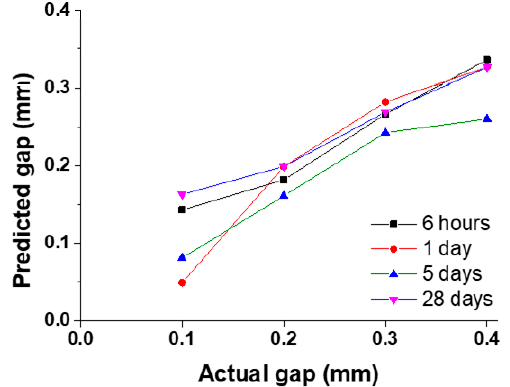
Figure 7. Predicted gap vs. actual gap between aluminium plate and concrete after 6 h, 24 h, 5 days and 28 days of concrete casting.